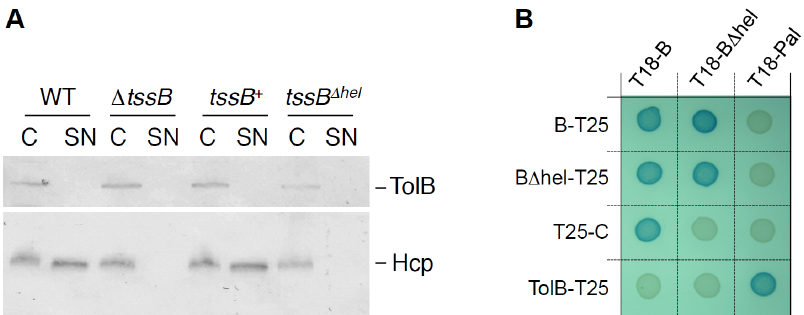
Figure 2. The a -helix located between residues 104 and 130 of TssB1 is required for T6SS function and interaction with TssC1. (A) Hcp release assay. Hcp FLAG release was assessed by separating whole cells (C) and culture supernatant (SN) fractions from 2 6 10 9 wild-type (WT), D tssB1 ( D tssB ) cells or D tssB1 cells producing TssB1 ( tssB + ) or TssB1 deleted of the a -helix 104-130 ( tssB D hel ). Proteins were separated by 12.5%- acrylamide SDS-PAGE and Hcp was immunodetected using anti-FLAG monoclonal antibody (lower panel). The periplasmic TolB protein (immunodetected using an anti-TolB polyclonal antibodies, upper panel) was used as a marker to verify that no lysis occured. (B) Bacterial two-hybrid assay. BTH101 reporter cells carrying pairs of plasmids producing the indicated T6SS proteins (B, TssB1; B D hel, TssB1 deleted of the a -helix; C1, TssC1) fused to the T18 or T25 domain of the Bordetella adenylate cyclase were spotted on X-Gal indicator LB agar plates.